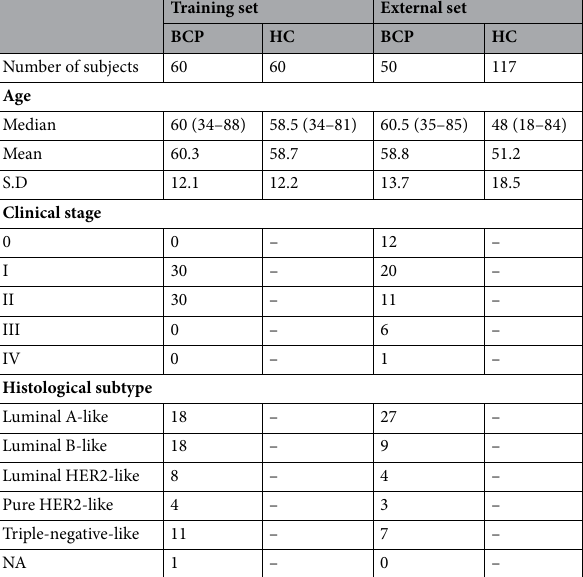
Table 1. Subjects enrolled in the study. BCP breast cancer patient, HC healthy control, NA not applicable, S.D. standard